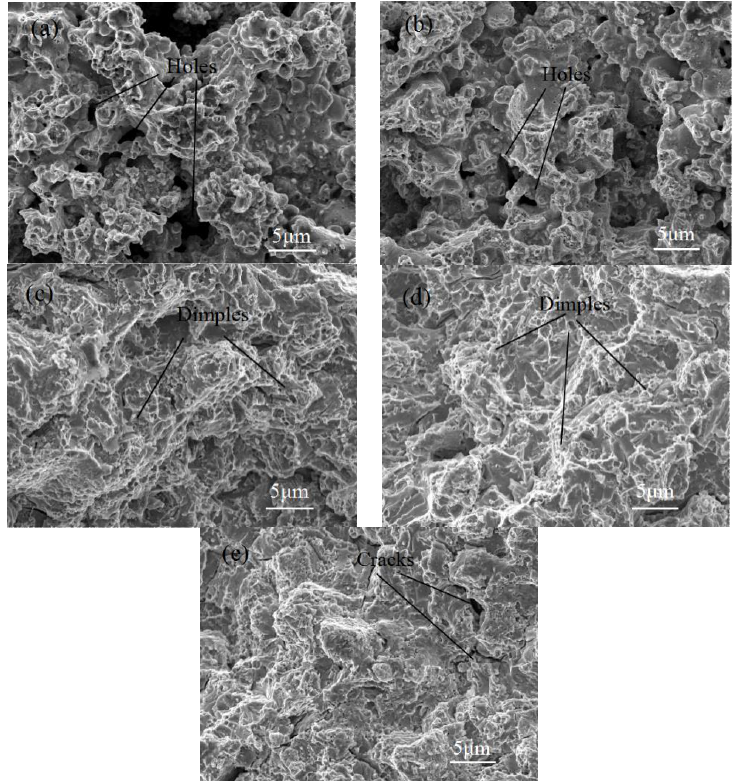
Figure 6. The fracture surfaces of TRS specimens containing rare earth Ce ( a ) 0 wt %; ( b ) 0.25 wt %; ( c ) 0.5 wt %; ( d ) 0.75 wt %; ( e ) 1.0 wt %. ( c ) 0.5 wt %; ( d ) 0.75 wt %; ( e ) 1.0 wt